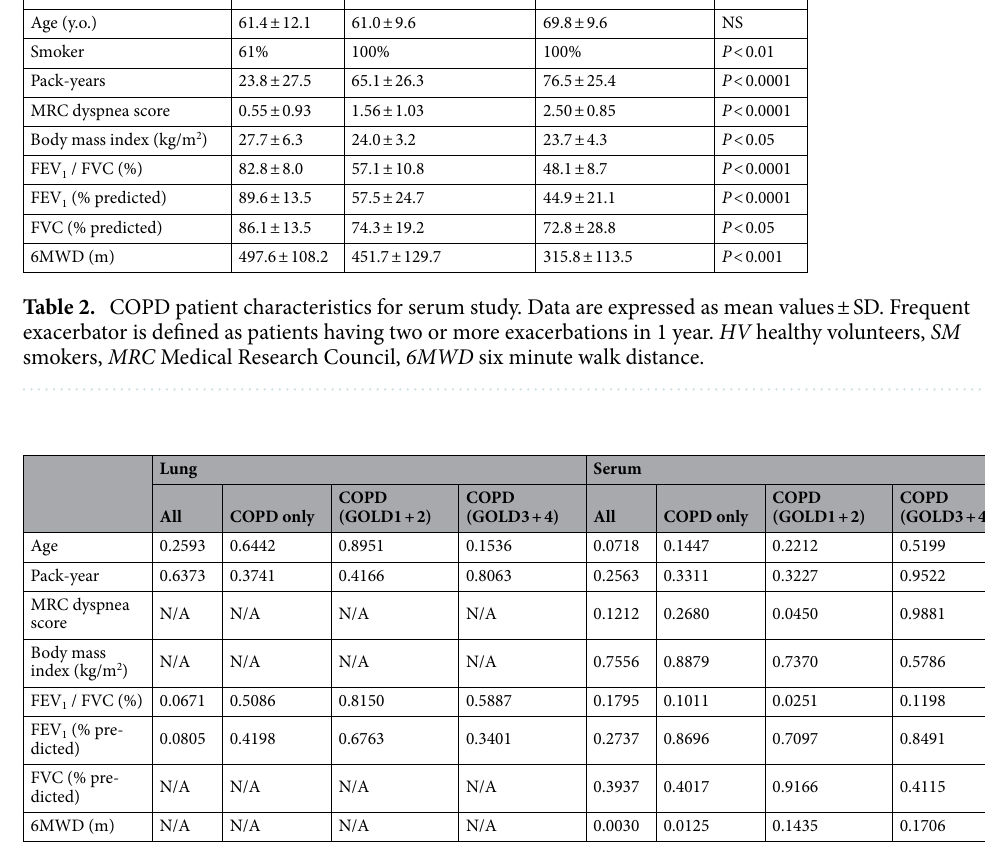
Table 3. Correlation of lung and serum galectin-8 with clinical parameter. Data are P values of correlation coefficient. N/A not available, MRC Medical Research Council, 6MWD six minute walk distance, GOLD Global Initiative for Chronic Obstructive Lung